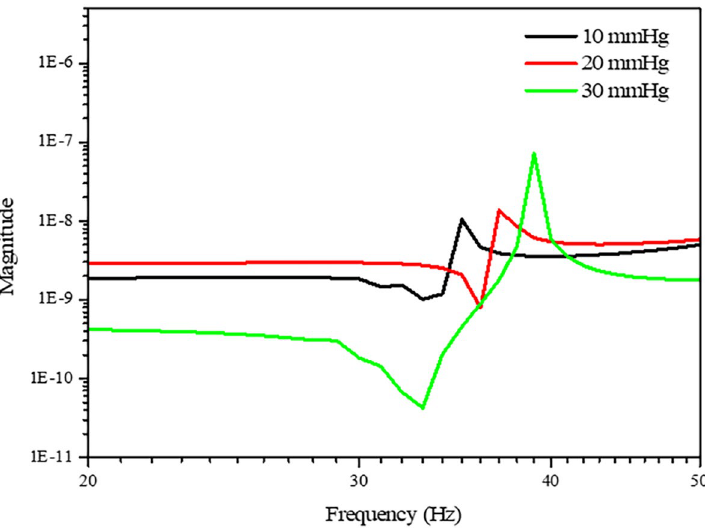
Figure 2. FEM analysis result of the eyeball vibration responses according to IOP